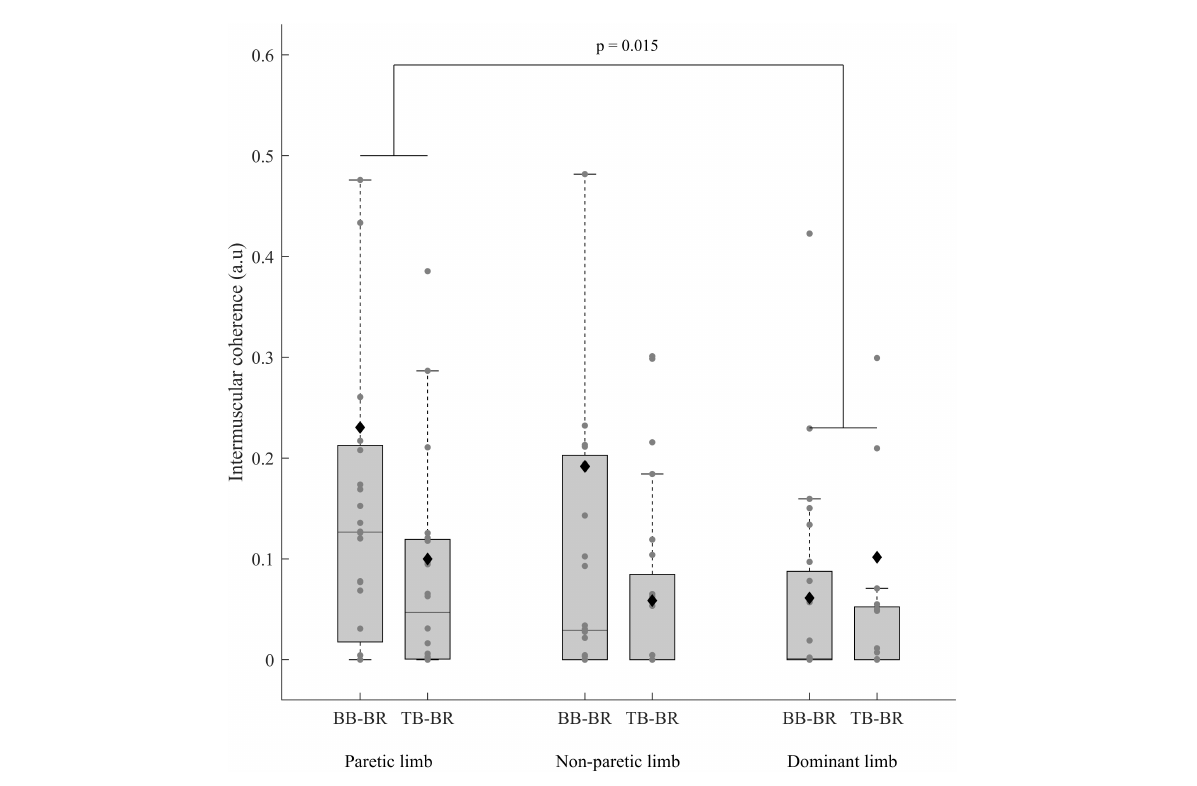
FIGURE5 IMC (before BoxCox transformation) of the paretic and non-paretic limbs of stroke subjects ( n = 24) and the dominant limb of control subjects (n = 24) for both the antagonist-antagonist and agonist-antagonist muscle pairs (Biceps brachii-Brachioradialis (BB-BR) and Triceps brachii-Brachioradialis (TB-BR)). The p -values shown in the figure are for the effect of a limb in the ANCOVA. In each box, the center line represents the median, the top, and bottom of the box correspond to the 25th and 75th percentiles, and the whiskers represent the 10th and 90th percentiles. The diamond markers represent the mean of each